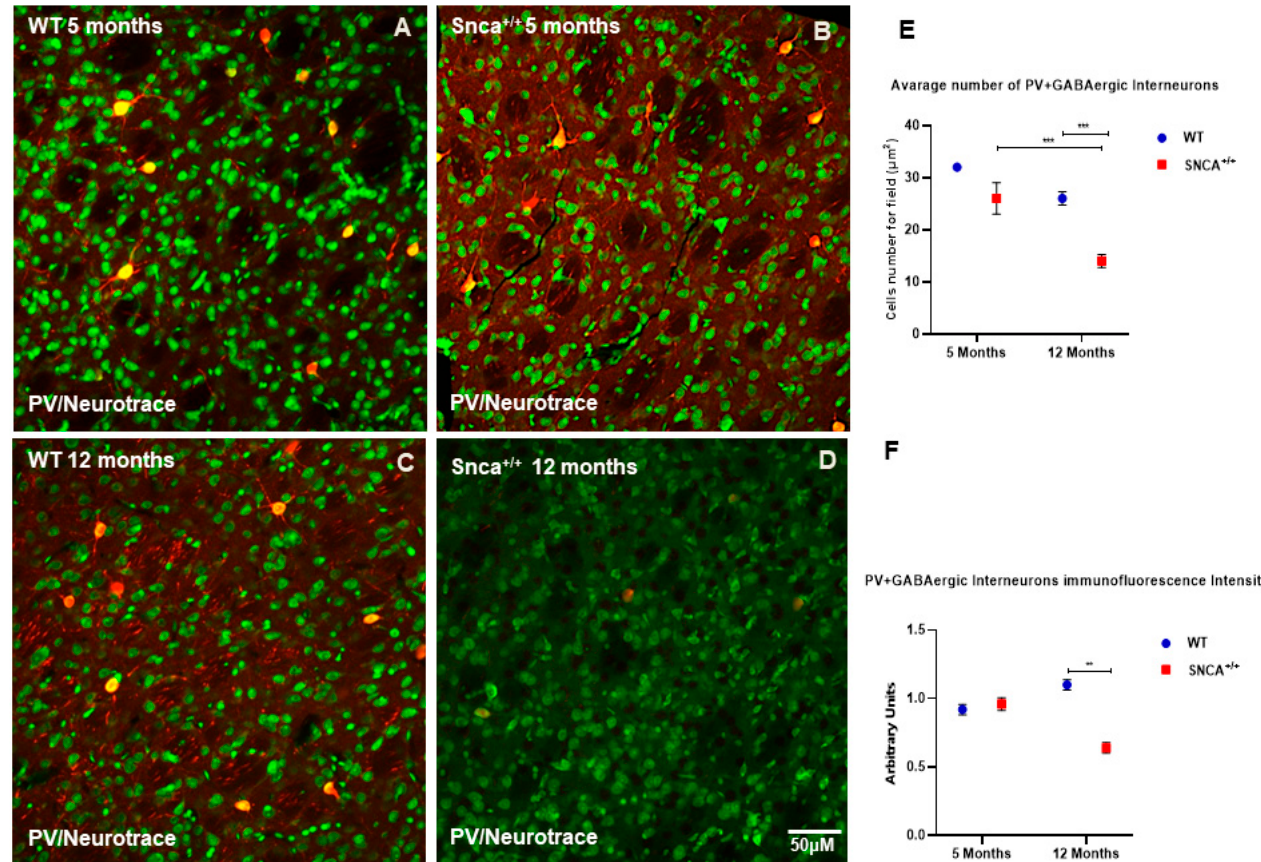
Figure 3. PV+ GABAergic distribution. Representative confocal microscopy-acquired images of single-label immunofluorescence for PV counterstained with Neurotrace. ( A – D ) Images show the shape and immunoreaction intensity of Pv+ GABAergic interneurons in each experimental group. ( E , F ) Two-way ANOVA analysis performed on data obtained from 5- and 12-month-old WT and Snca +/+ showed a statistically significant reduction in number [genotype and time effect F(1.25) = 23.40 *** p < 0.001] and intensity [genotype effect F(1.207) = 10.80 ** p < 0.0012] of Parvalbumin-positive striatal neurons in 12-month-old Snca +/+ rats.